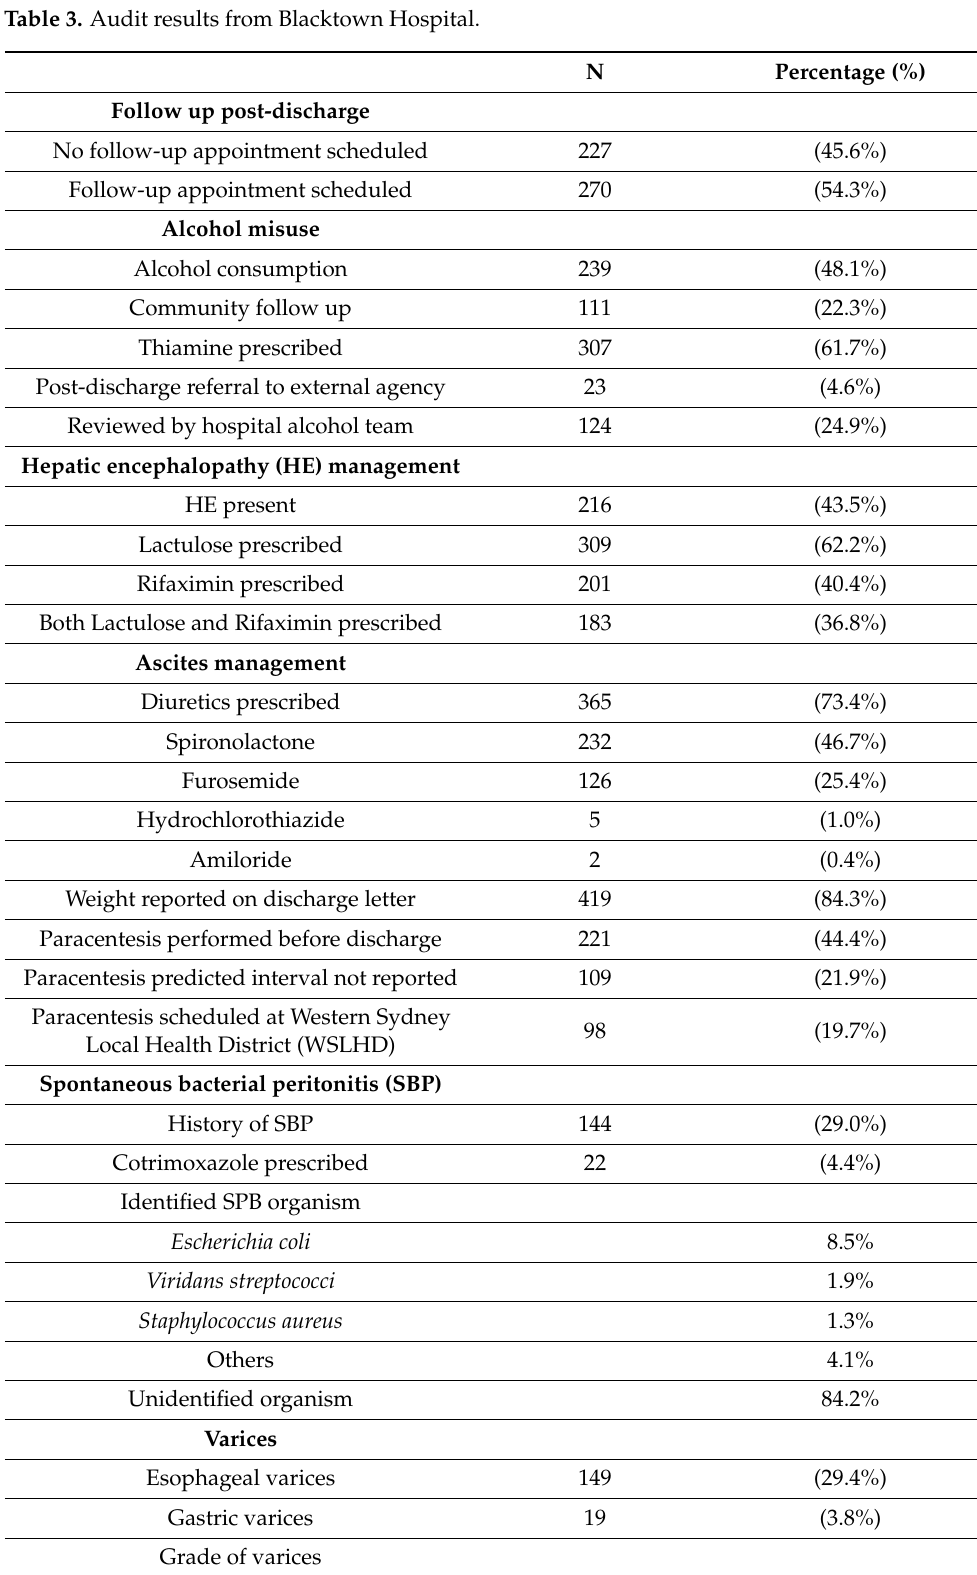
Table 3. Audit results from Blacktown